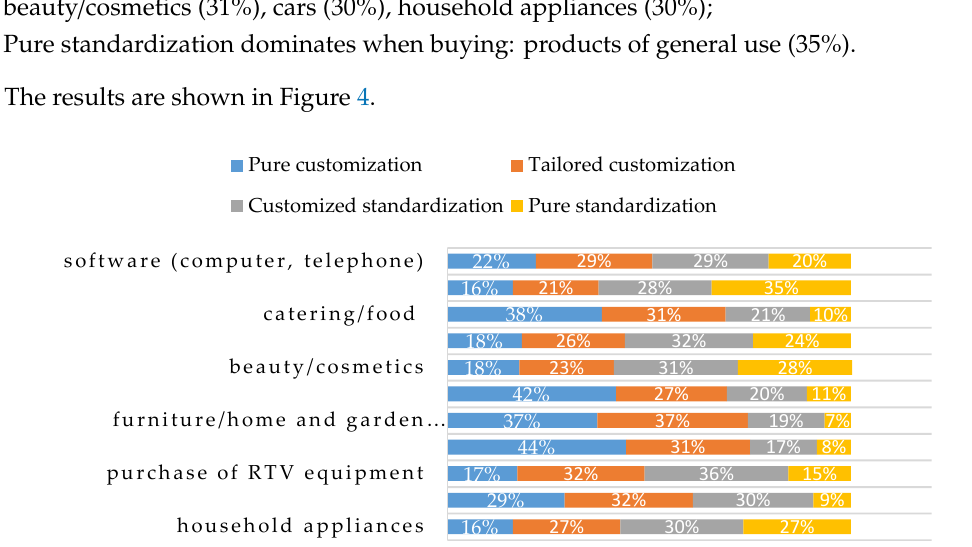
Figure 4. Expected customization variants for individual product groups. Source: own study.